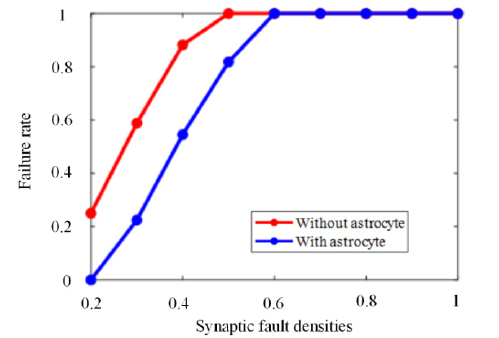
Figure 7. Failure rates at different synaptic fault densities.